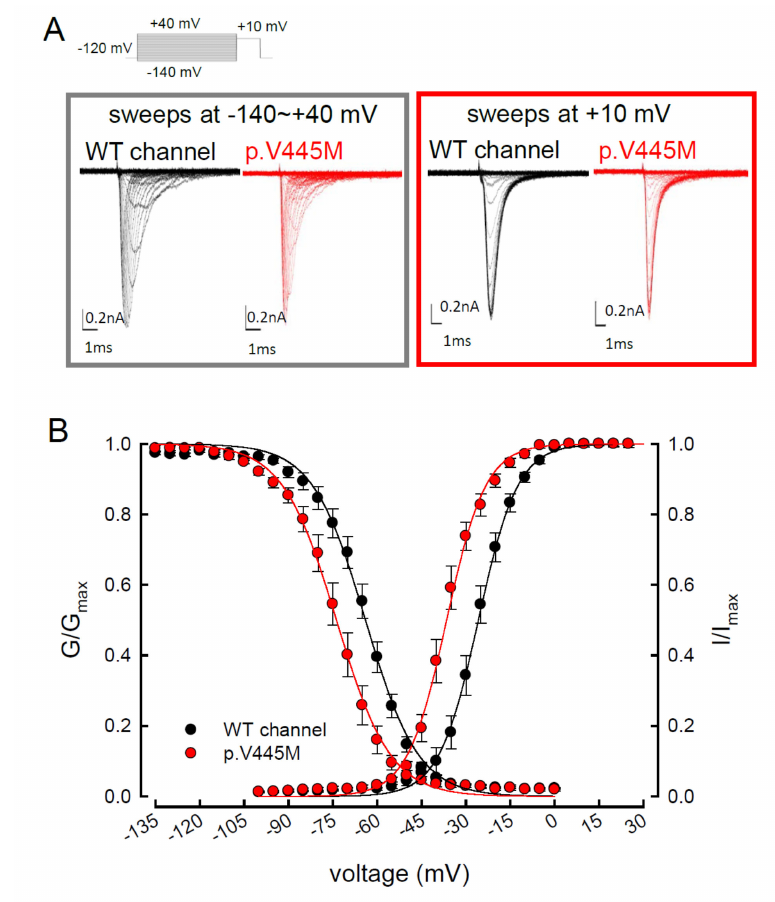
Figure 2. Activation and inactivation curves of wild-type (WT) and p.V445M mutant channels in the CHO-K1 cells. ( A ) Sample sweeps of the activation (left panel) and inactivation (right panel) curves of the WT and p.V445M mutant channels with 0.1 mM Na v β 4 peptide. For the current-voltage (I-V) plot, each patch cell configuration was held at − 120 mV, and step test pulses were from − 140 to + 40 mV for 100 ms in each 5 mV escalation and plotted against test pulse voltage where each with 5 potential step. For the inactivation curve of Na + currents, the maximal currents at + 10 mV were documented after 100 ms prepulses at various voltages. ( B ) The activation and fast steady-state inactivation curves of the WT and p.V445M mutant channels are fitted with a Boltzmann function according to the following formula: 1 / [1 + exp((V h − V) / k )], where V is the membrane potential, V h and k are − 25.79 ± 1.5 mV and 6.67 ± 0.43 for the activation curve and − 63.99 ± 2.17 mV and − 8.93 ± 0.33 for the inactivation curve in the WT Na v 1.4 channel; − 36.53 ± 1.4 mV and 6.61 ± 0.23 for the activation curve and − 73.81 ± 1.2 mV and − 9.11 ± 0.21 for the inactivation curve in the p.V445M mutant channel, respectively ( n = 9 for each